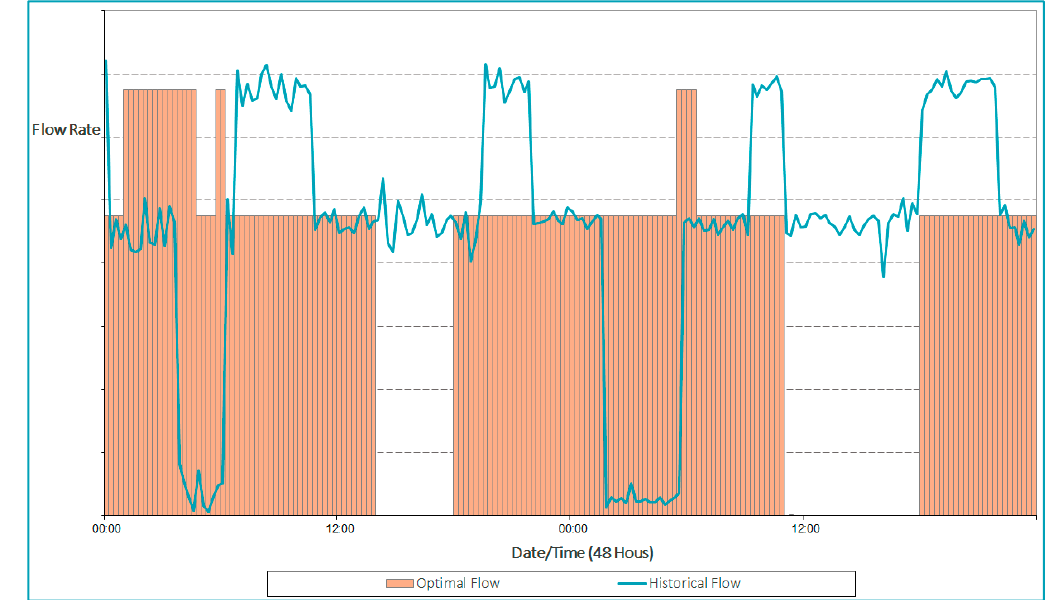
Figure 5. Sample Flow